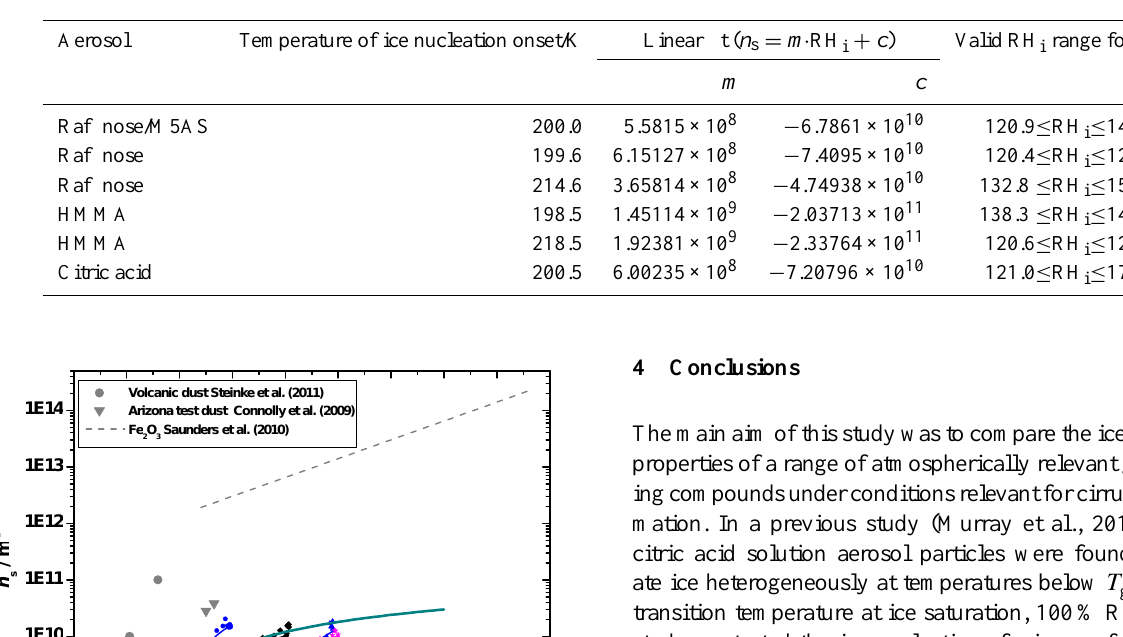
Table 2. Parameters for the linear fits to n s shown in Fig. 10 and Fig. 11 as a function of RH i . Also included is n s for glassy citric acid aerosol, calculated based on a parameterisation of f ice vs. RH i (Murray et al., 2010). Note that each fit is only valid for the range of RH i shown in the rightmost column of the table.